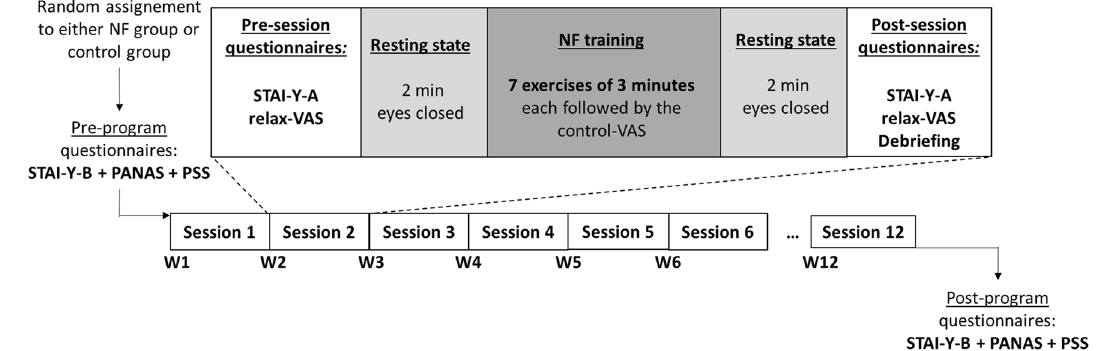
Figure 2. Timeline of the experimental protocol. Before and after the NFT program, the participants completed three psychometric trait questionnaires, to assess psychological stress (Perceived Stress Scale— PSS ) 67 , trait anxiety ( STAI-Y-B ), and affectivity (Positive and Negative Affect Schedule— PANAS ). NFT was performed over 12 weeks (W1, W2, … W12), with one training session per week (Session 1,… , Session 12). See main text for detailed description of the